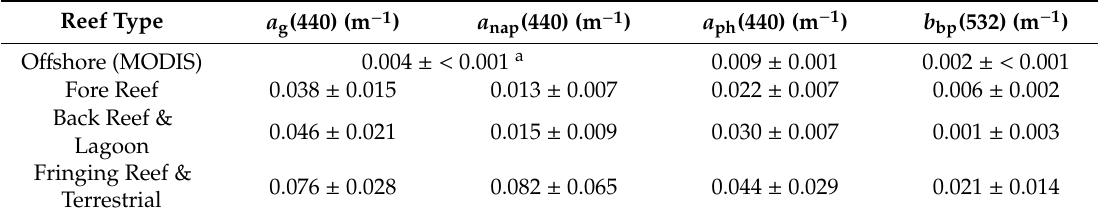
Table 4. Median inherent optical properties measured across di ff erent reef zones compared to values derived o ff shore from MODIS satellite imagery for the similar time period.